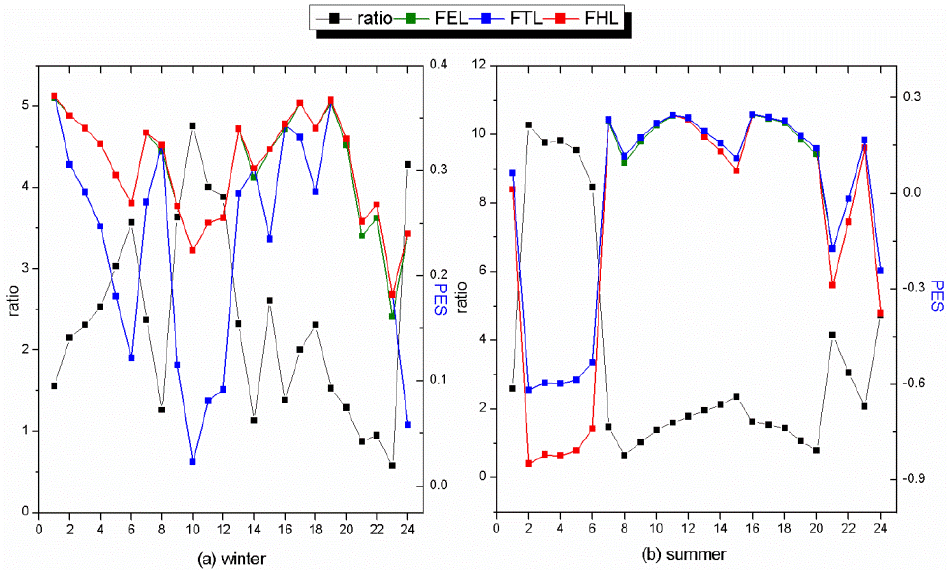
Figure 5. Ratio of thermal demand to electricity and PES of different operation mode in